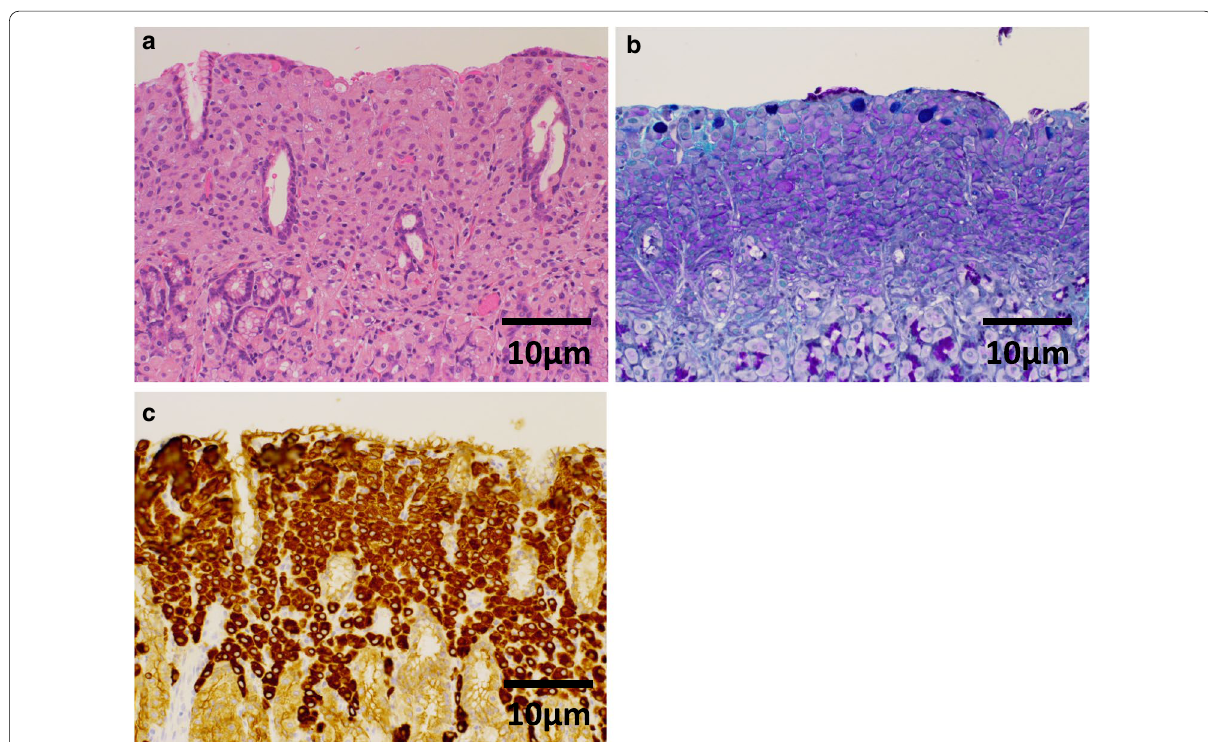
Fig. 4 Microscopic image of lesion (O) at Fig. 3. a Hematoxylin–eosin (HE) staining, b Periodic Acid-Schiff (PAS) and alcian blue staining, and c immunostaining of pan-cytokeratin (clone: AE1/AE3). HE staining shows that atypical cells with hyperchromatic nuclei were proliferating in the lamina propria. The lesion contains PAS staining positive, pan-cytokeratin (clone: AE1/AE3) positive cells. No lymphatic or vascular invasion was observed